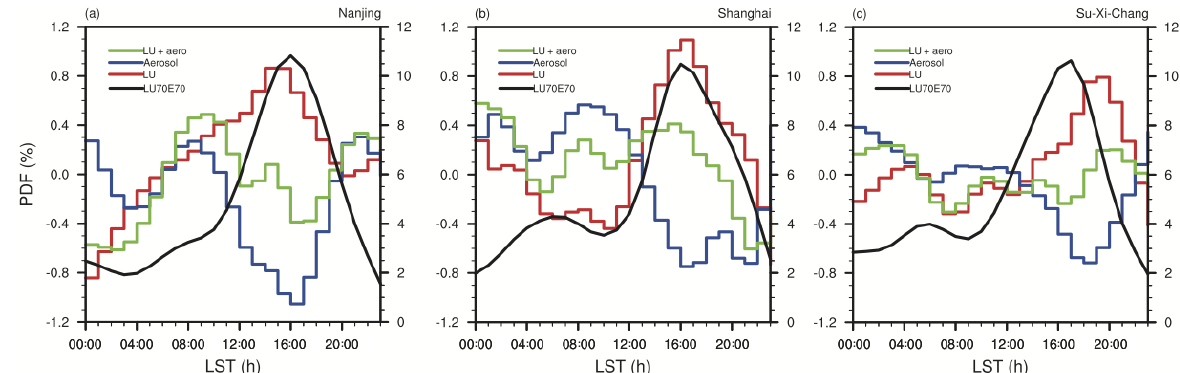
Figure 8. Diurnal cycles of the frequency of summertime extreme rainfall events for LU70E70 (defined using hourly precipitation intensity above 95th percentile; black lines, right axis) and the differences between simulations over (a) Nanjing, (b) Shanghai, and (c) Su-Xi-Chang. Red lines are for land-use effect, blue lines for aerosol effect, and green lines for the combined effect.